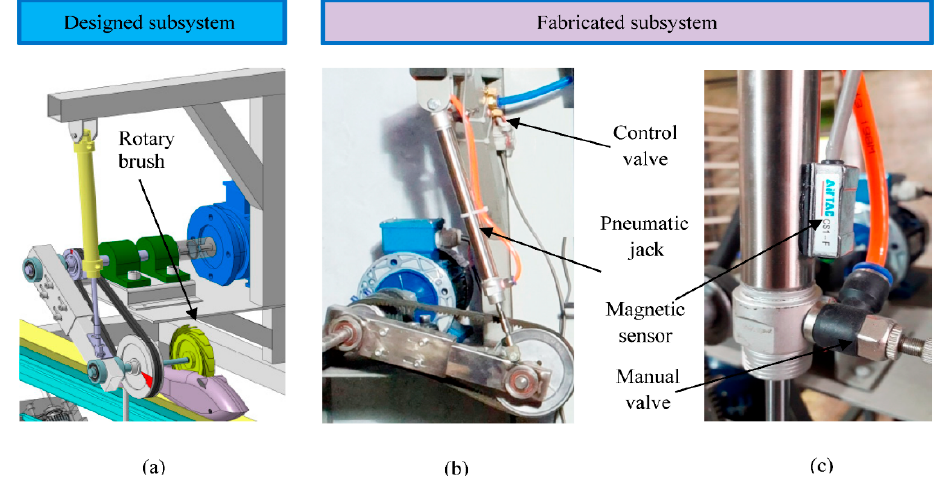
Figure 9. Fish cleaning subset: ( a ) designed subsystem, ( b ) fabricated subsystem, and ( c ) applied sensor.